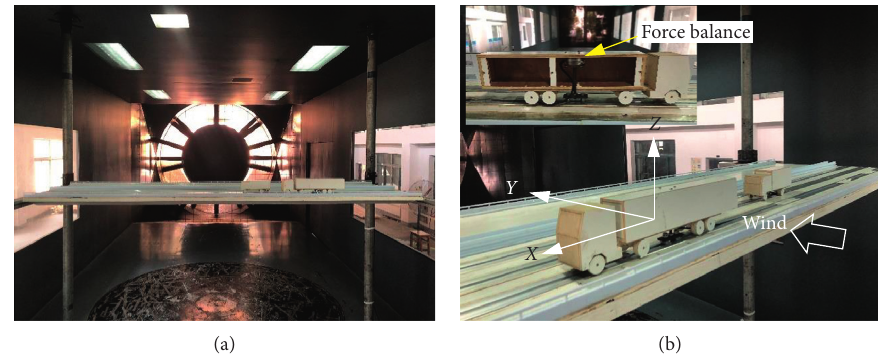
Figure 3: The vehicles and bridge in the wind